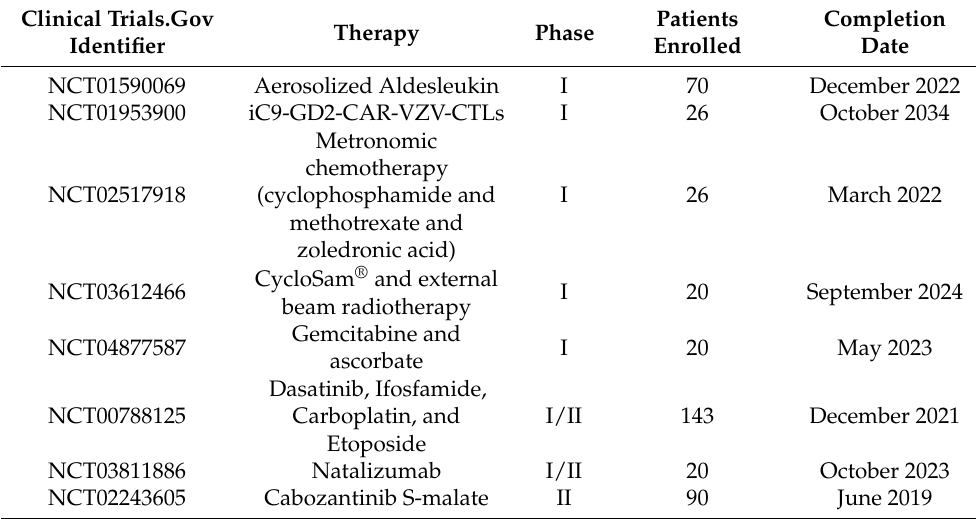
Table 3. Summary of ongoing metastatic osteosarcoma clinical trials. Clinical